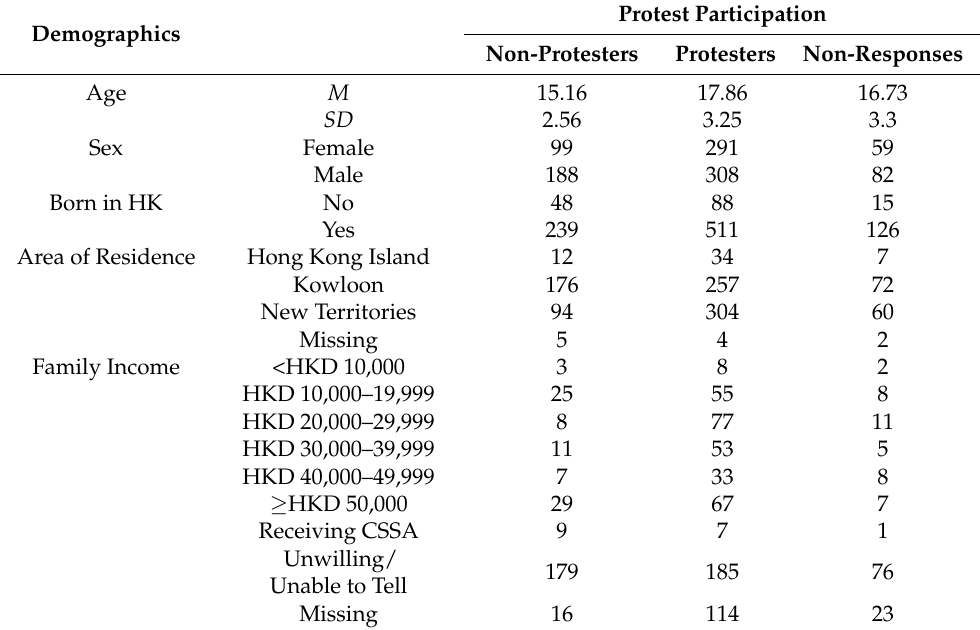
Table 1. Demographic Characteristics of Participants by Protest